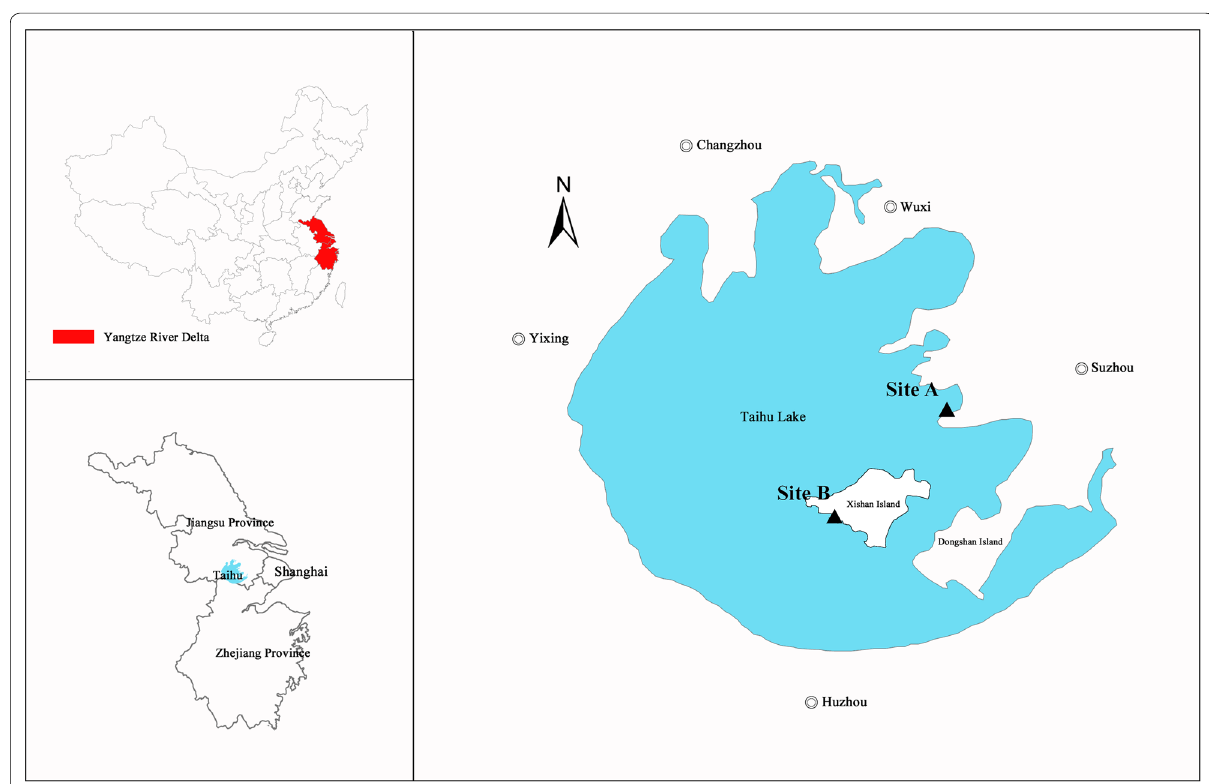
Fig. 1 Location of the Yangtze River Delta in China and caging sites in Taihu Lake (solid triangles represent caging sites A and B; double circles around the lake are major cities with population over one